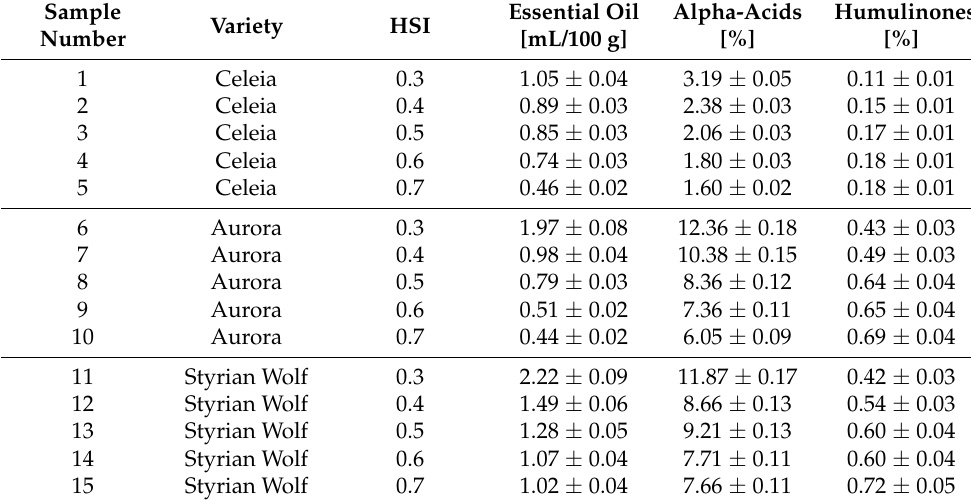
Table 2. Content of hop essential oil, alpha acids and humulinones in hop samples, presented as mean value ± standard